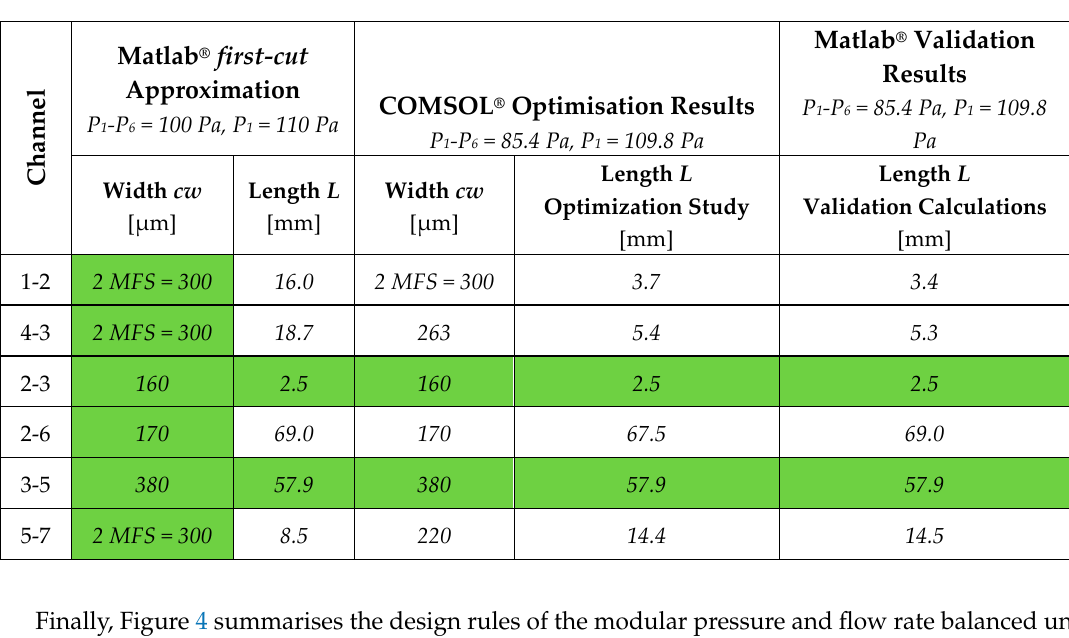
Sensors 2019 , 19 , x FOR PEER REVIEW 11 of 19